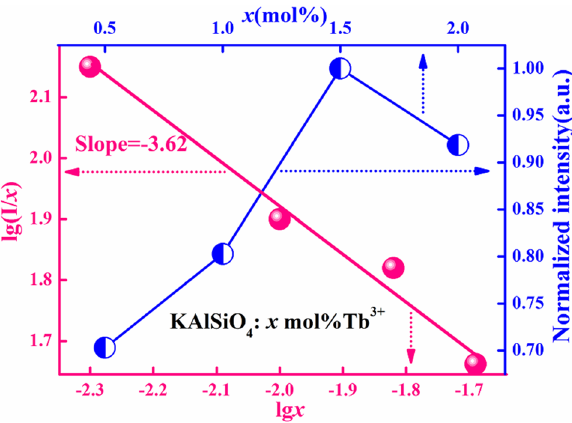
Figure 4. Concentration quenching mechanism diagram for KAlSiO 4 : x mol% Tb 3+ ( x = 0.5, 1, 1.5,